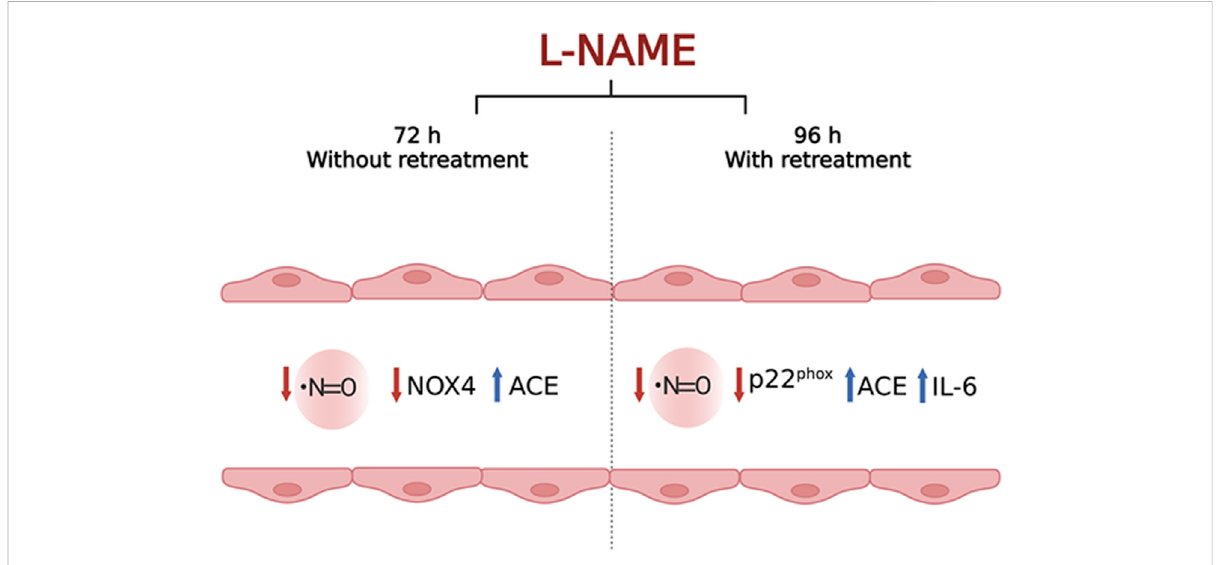
possiblyassociatedwithincreasedlevelsofthevasoconstrictorangiotensinII.At96 hofL-NAMEexposition,endothelialcellsshoweddecreasedNO availability,decreasedp22 phox